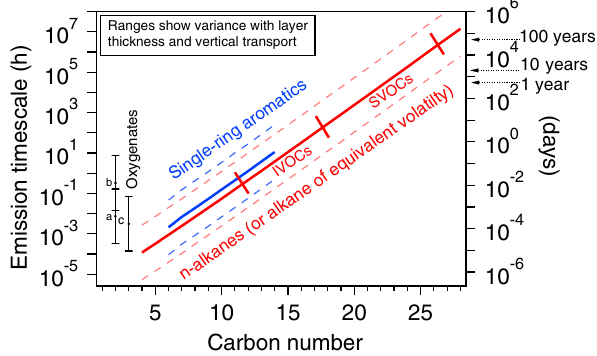
Figure 4. Emission timescales for single-ring aromatics, alkanes, and prominent solvents: ethanol (a) , ethylene glycol (b) , and ace- tone (c) . Based on applied layers of 0.01–1mm and vertical trans- port coefficients for neutral and stable outdoor conditions (10– 50mh − 1 ), with longer timescales in indoor environments or thicker layers (e.g., asphalt, building materials). The left axis is reproduced on the right in days. Timescales are limited by gas-phase transport from the surface, but absorption into polymeric or porous substrates could extend timescales (Weschler and Nazaroff, 2008). Volatility range boundaries for VOC–IVOC and IVOC–SVOC occur between C 12 –C 13 and C 19 –C 20 , respectively, for n -alkanes or compounds with equivalent volatilities. See Appendix B for calculations